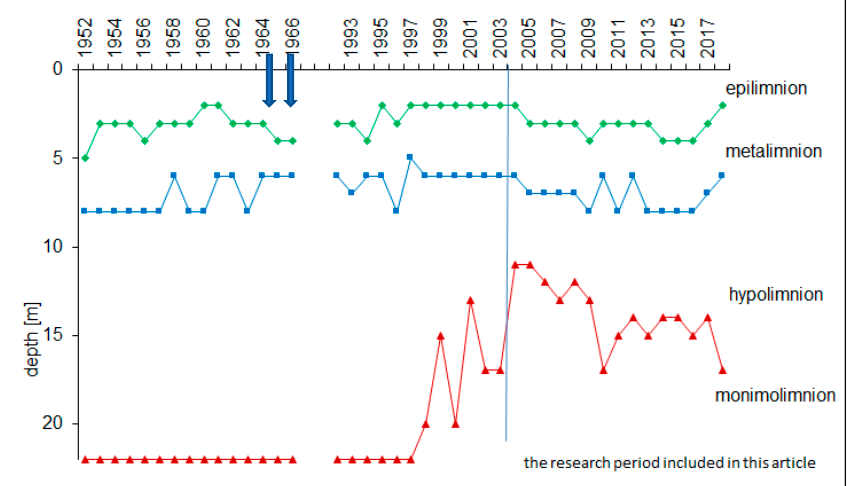
Figure 2. The range of thermal layers in the peak summer stagnation period (August) during the whole observation time. The research period included in this article is shown on the right-hand side. The blue arrows show the aluminium sulphate treatment.